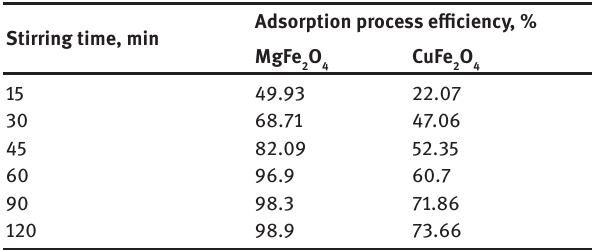
Table 2: The influence of the stirring time upon the adsorption process